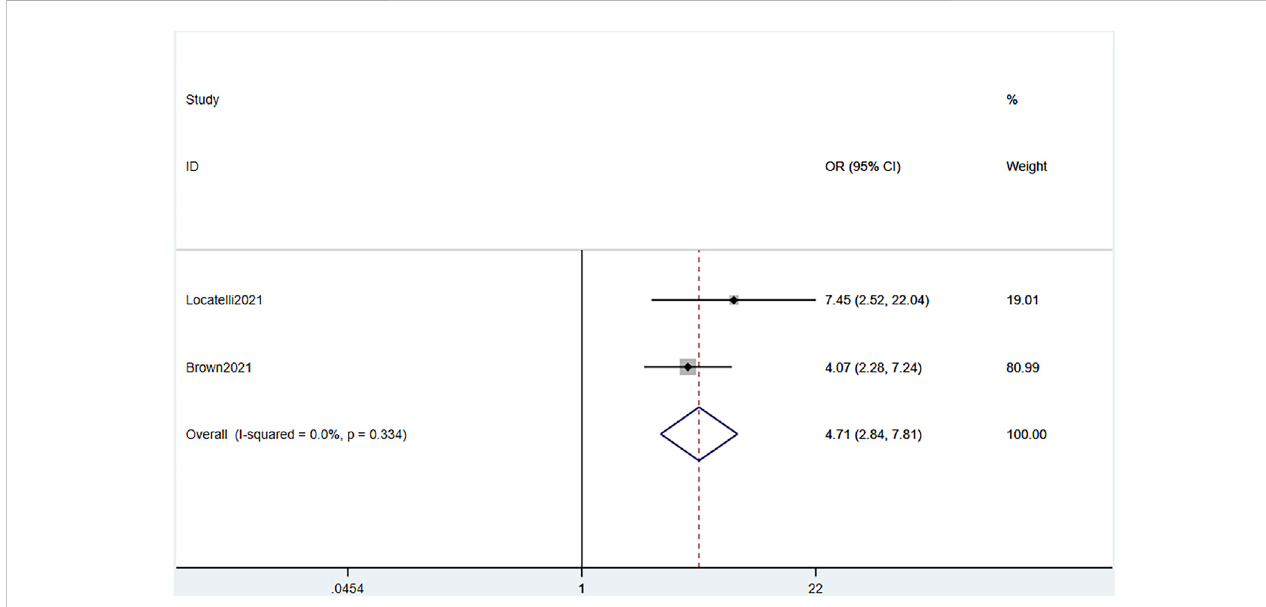
FIGURE 7 Forest plot of MRD (RCTs). MRD, minimal residual disease; RCTs, randomized clinical trials; 95% con fi dence interval; OR: odds ratio. The size of the rectangle at the center of the horizontal bar is proportional to the weight of the given study. The diamond at the bottom indicates the pooled OR.